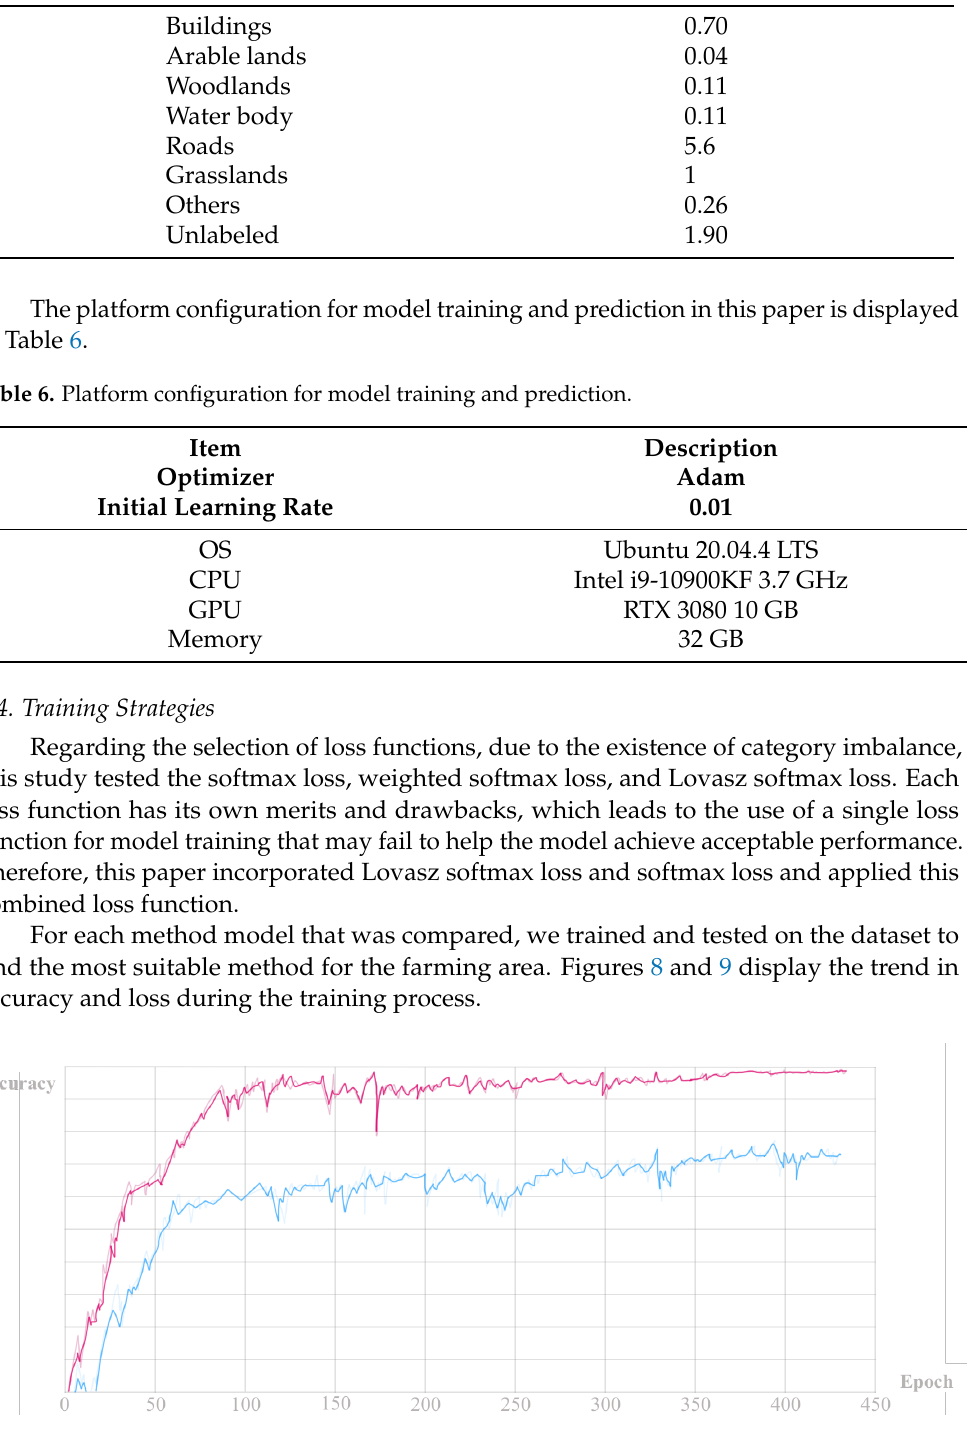
Figure 8. Training curves of accuracy against number of epochs (red: training set; blue: validation set). The model parameters used in this paper are selected as the optimal parameters when the loss function converges on the training set in Figure